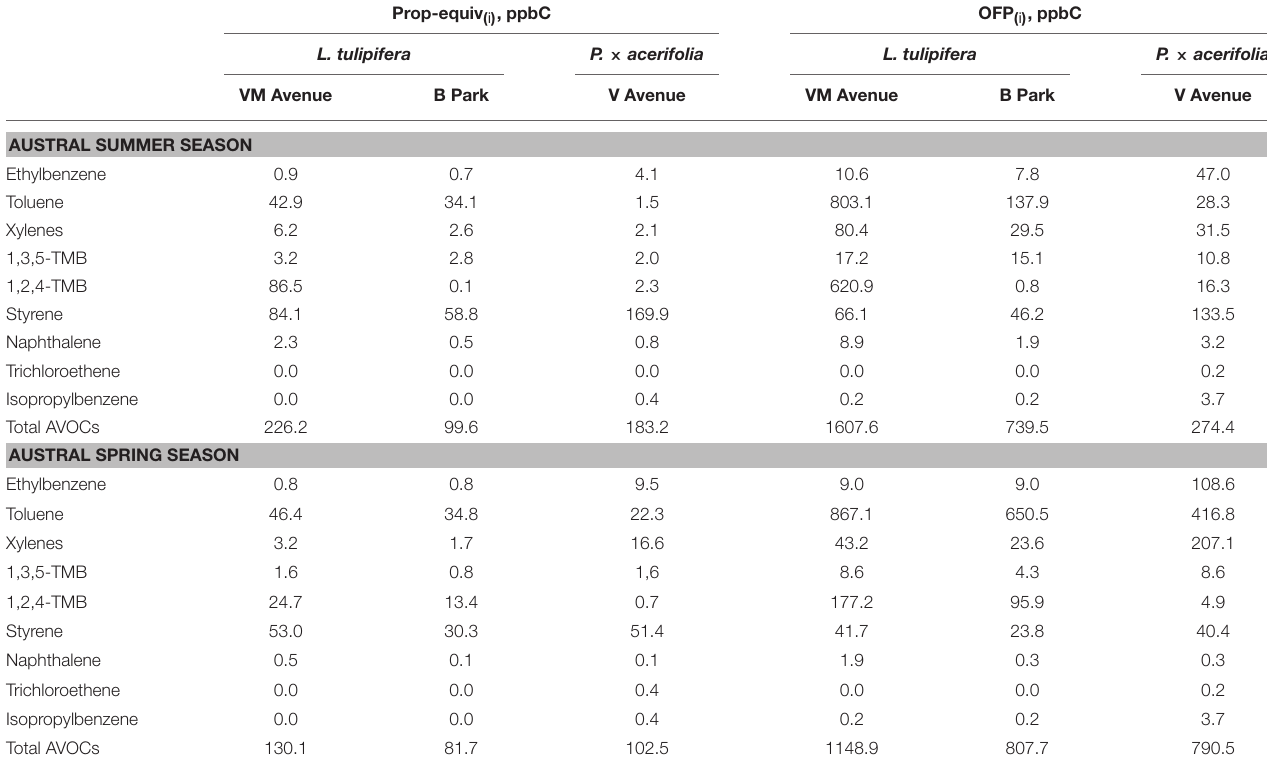
TABLE 2 | Prop-equiv (i) concentration (ppbC) and OFP (i) (ppbC) of AVOCs at VM Avenue, B Park and V Avenue sites, for austral summer season, and austral spring. Prop-equiv ( i ) , ppbC OFP ( i ) ,